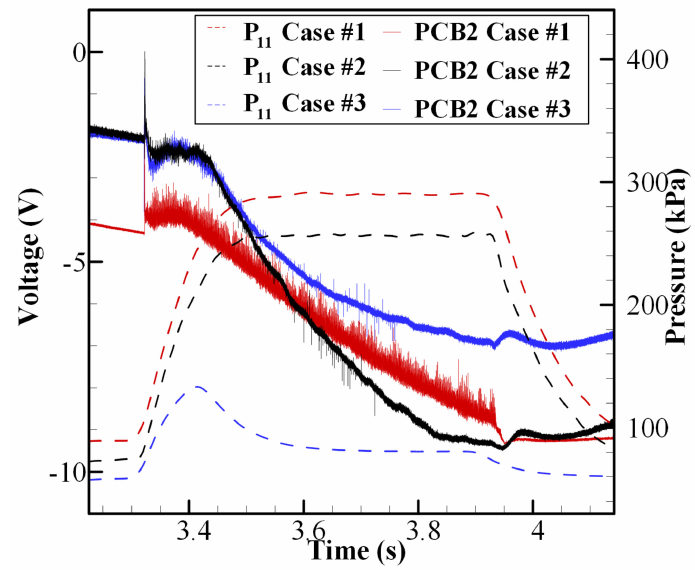
Figure 4. The original voltage signals and the static wall